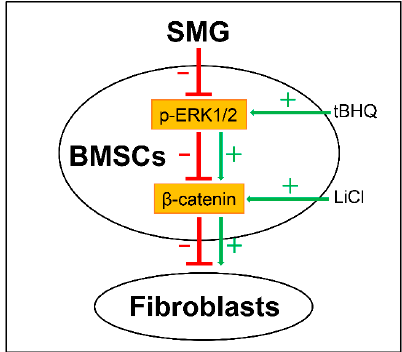
Figure 6. Proposed a model by which SMG inhibits ERK/ β -catenin signaling pathway and thus suppresses dermal fibroblastic differentiation of BMSCs. After exposure to SMG, phosphorylation of ERK1/2 was decreased and the Wnt/ β -catenin signaling was downregulated, followed by the inhi- bition of dermal fibroblastic differentiation. After LiCl treatment, the Wnt/ β -catenin signaling was upregulated and thus dermal fibroblastic differentiation of BMSCs was recovered under SMG con- ditions. After tBHQ treatment, phosphorylation of ERK1/2 was enhanced, and thus the Wnt/ β - catenin signaling was improved under SMG conditions. Collectively, SMG could suppress ERK/ β - catenin to inhibit dermal fibroblastic differentiation of BMSCs. SMG: simulated microgravity; BMSCs: bone marrow-derived mesenchymal stem cells; p-ERK1/2: phosphorylation of extracellular regulated protein kinases 1/2; tBHQ: tert-Butylhydroquinone; LiCl: lithium chloride. “+”/color green lines indicate stimulation; “–”/color red lines indicate inhibition.